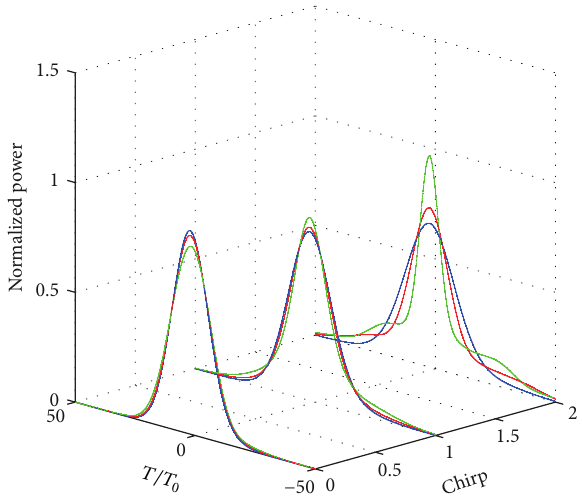
Figure 4: The resulted pulses with Δ𝑡 𝑤 = 30 ps 2 and 𝛽 2 = 1 ps 2 / km for different values of chirp and 𝑘